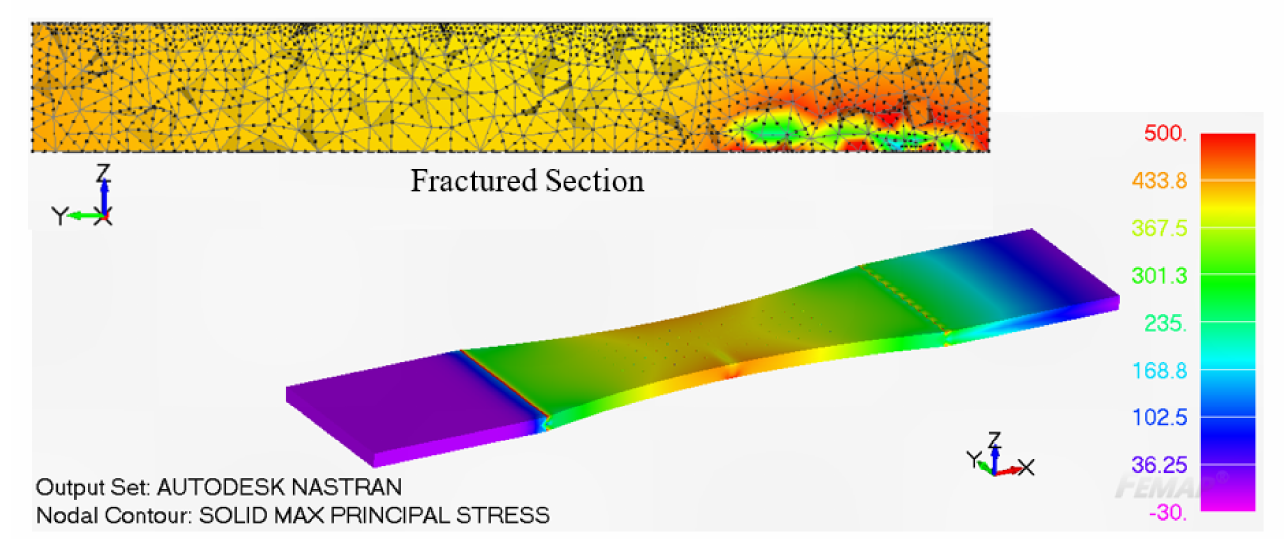
Figure 15. The maximum principal stress for Specimen 2 at a remote load of 50 kN, the stress units are in MPa.